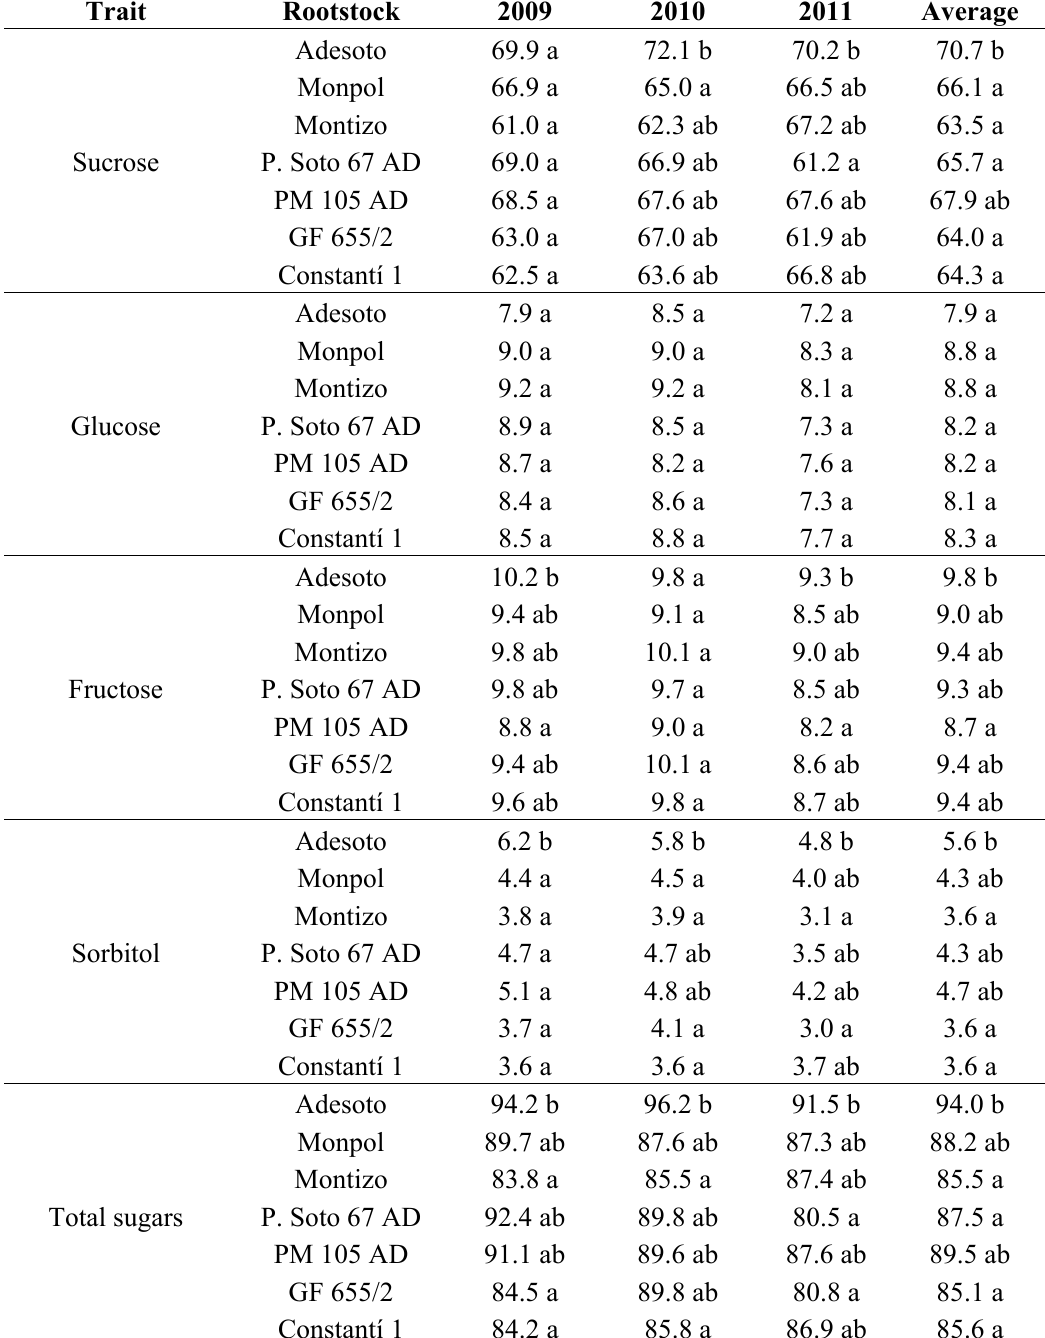
Table 3. Influence of different plum rootstocks on the individual and total sugars of “Catherine” peach fruits in the tenth (2009), eleventh (2010) and twelfth (2011) year after